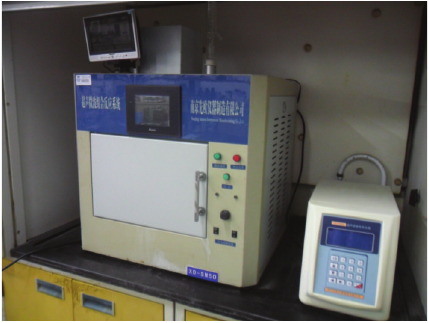
Scheme 1: Photo of the supersonic assisted microwave reactor.